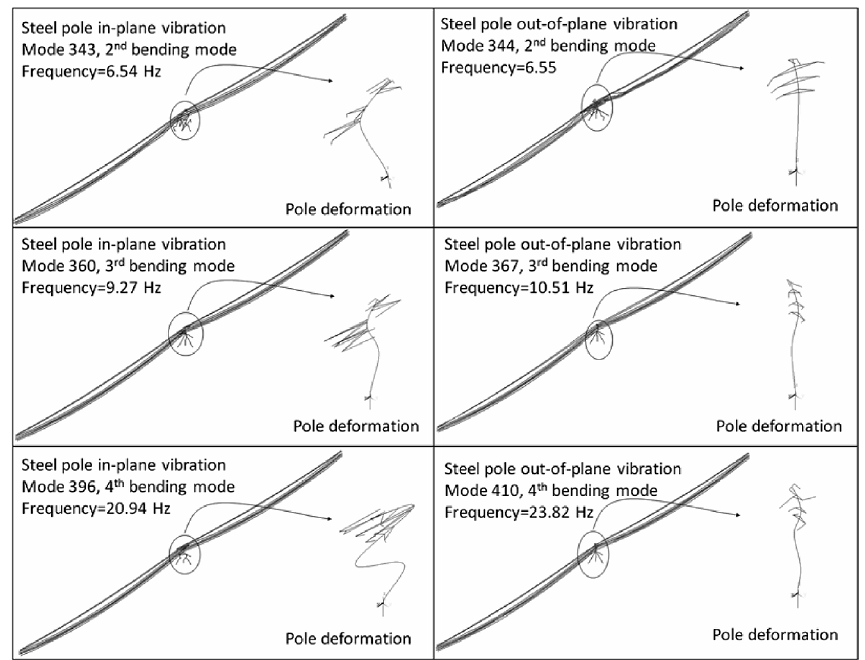
Fig. 4. Representative pole-leading modes of the coupled steel pole-line system.